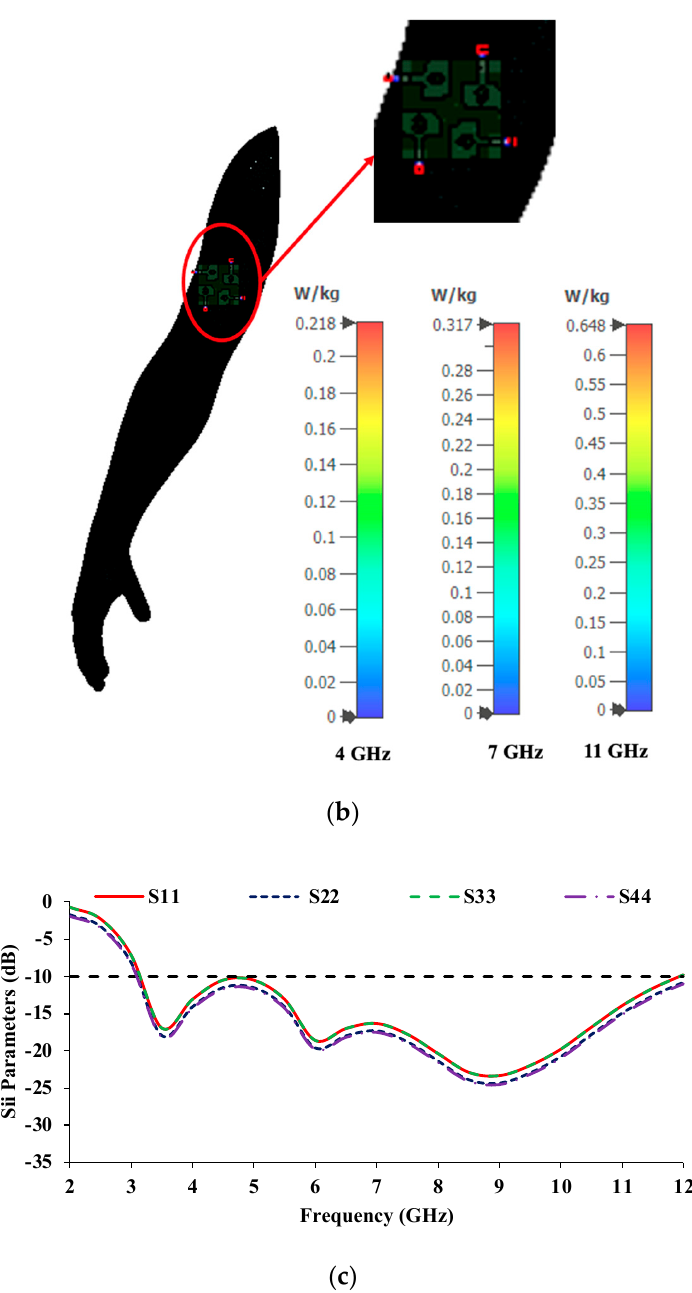
Figure 22. SAR analysis on an imported human body model (a) Chest, (b) Forearm, (c) Reflection coefficient curves.